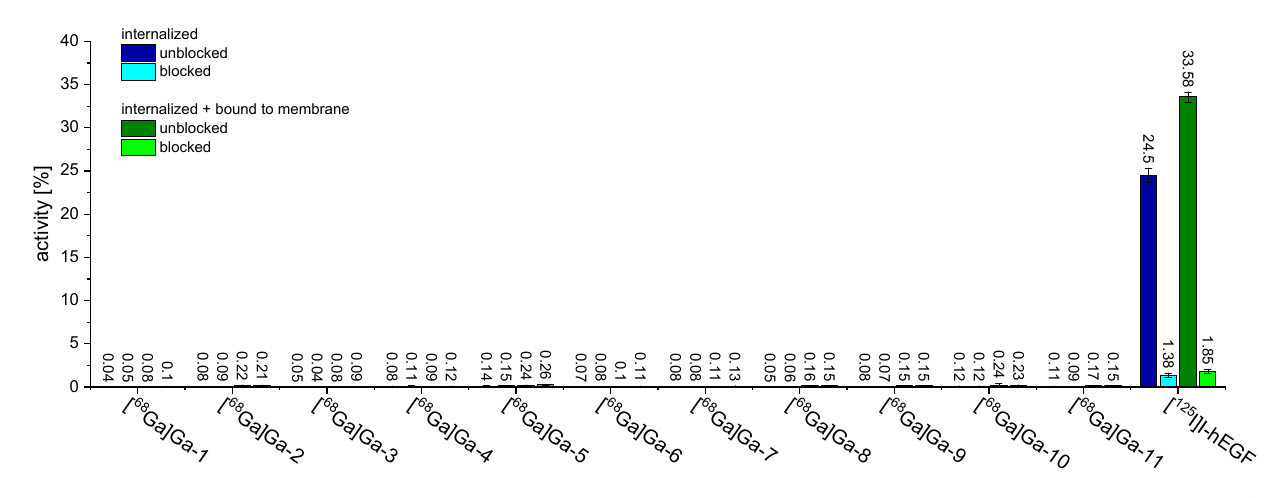
Figure 5. Summary of the results of the cell uptake studies of [ 68 Ga]Ga- 1 –[ 68 Ga]Ga- 11 and [ 125 I]I- hEGF on EGFR-positive A431 cells after 1 h of incubation under non-blocking and blocking conditions. Each experiment was performed thrice, each in triplicate.